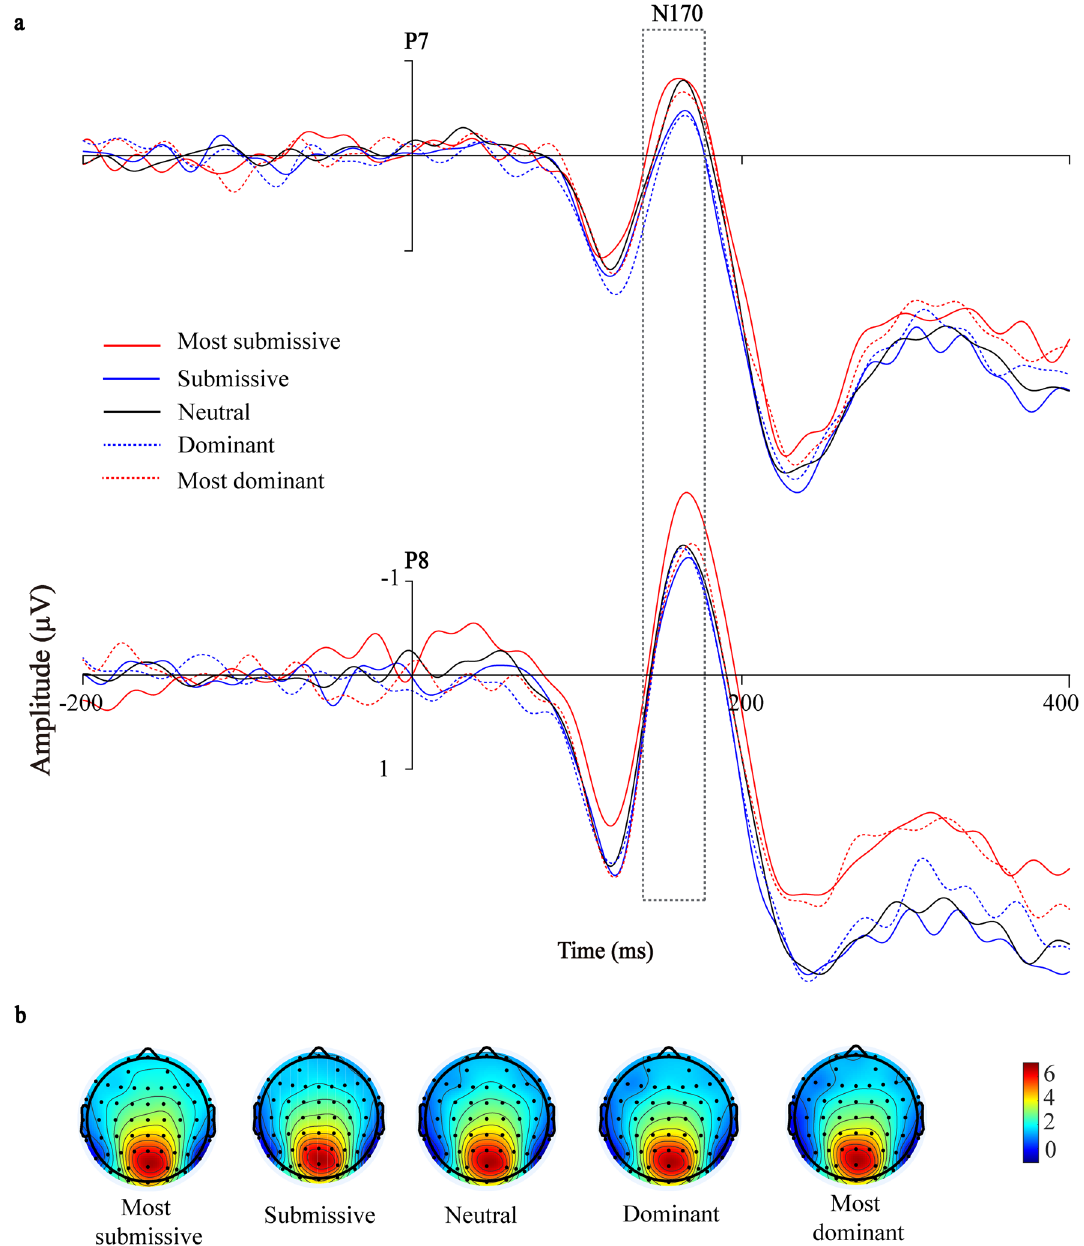
Figure 2. The N170 related to facial dominance evaluation. ( A ) The N170 over the temporo-parietal region (P7 and P8) as a function of dominance levels (− 3 SD, − 2 SD, 0 SD, + 2 SD, + 3 SD). ( B ) Topographical voltage distributions within 140–180 ms centered on the peak of N170 elicited by faces with different levels of dominance. Positive isopotential lines are in red and negative isopotential lines are in during the encoding of human faces. Here, it is noted that in those studies that show modulation of inferring dominance levels from human faces on the N170 26,27,31 , there exists a potential confounding effect induced by dominance-conveying symbols along with the faces or faces with dominant or submissive facial expressions on facial dominance judgments. This makes it impossible to determine whether the observed dominance level over N170 indeed reflects participants’ evaluation of facial dominance information or their assessment of dominance-conveying symbols along with the faces. To elucidate this issue, one possible solution could be to manipulate facial dominance features to eliminate such confounding effects. Following this perspective, the present approach manipulates facial dominance as features related to physical strength/weakness. This allows us to directly address the issue of whether facial dominance evaluation occurs during the early stage of face process- ing, and using this approach, no effect of facial dominance hierarchies on the N170 was found.